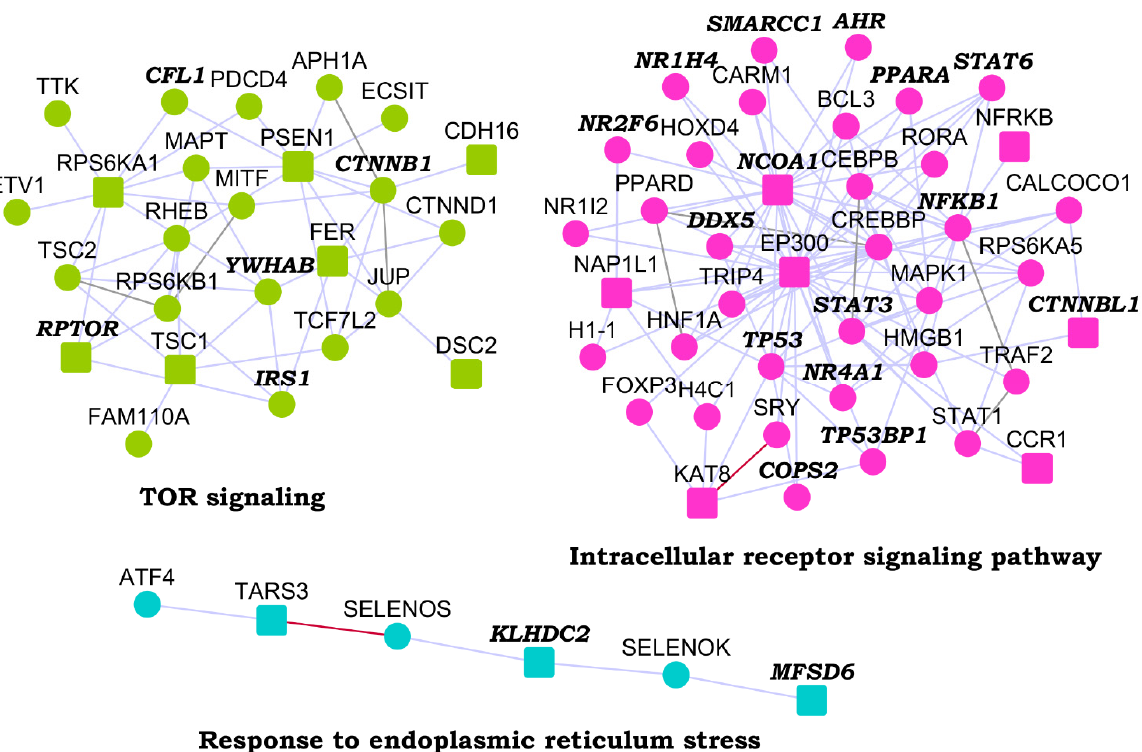
Figure 2. Modules identified from the hypoplastic left heart syndrome (HLHS) interactome: Three modules that were enriched in specific GO biological processes are shown. Within each module, nodes with bold italicized labels depict genes with at least one transcriptomic evidence relevant to HLHS. HLHS-associated genes are shown as square-shaped nodes and novel interactors and known interactors are shown as circular nodes. Red edges are the novel interactions, whereas blue edges are known interactions.